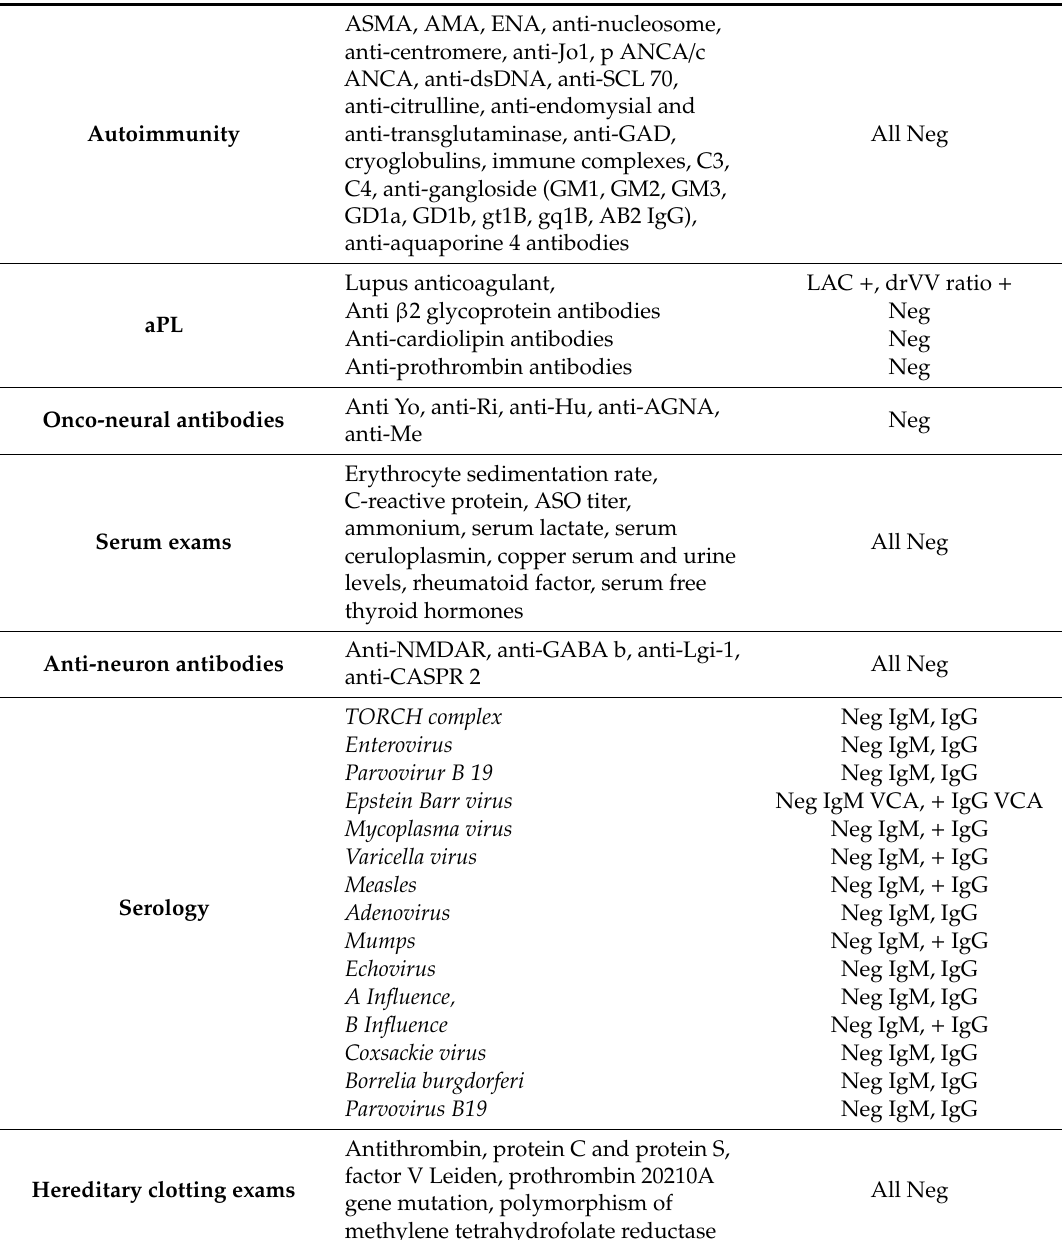
Table 1. Laboratory assessment before intravenous immunoglobulin treatment (IVIG)